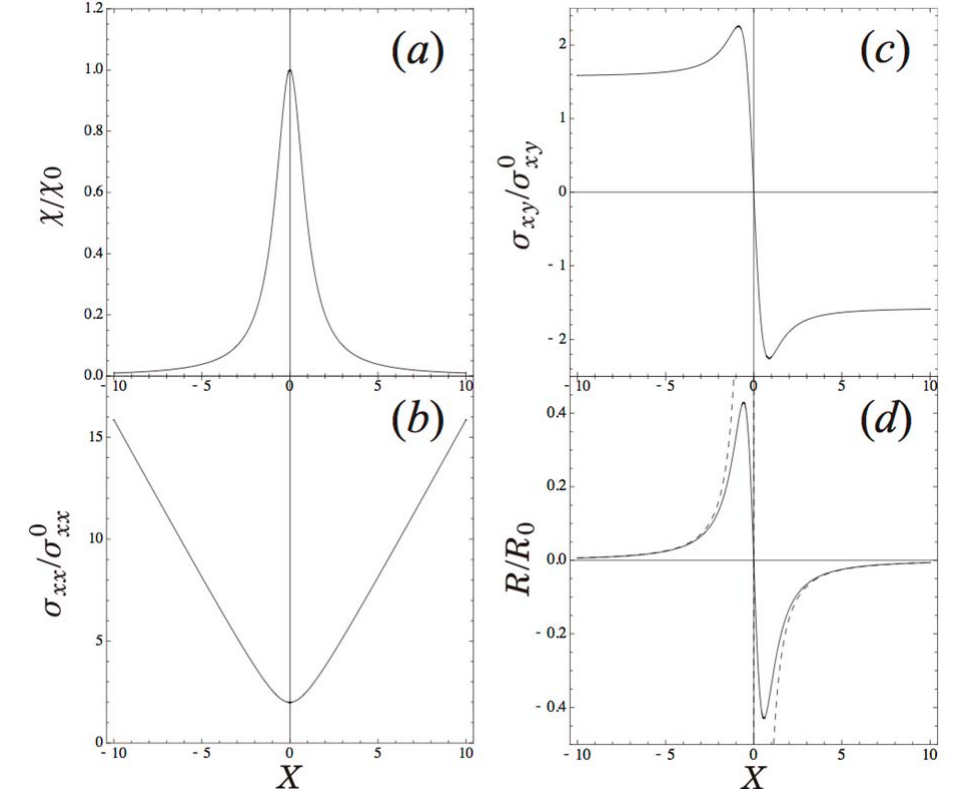
Figure 6. Chemical potential ( μ ) dependences of: ( a ) orbital susceptibility, χ ; ( b ) diagonal conductivity, σ ; ( c ) Hall conductivity, σ ; and ( d ) Hall coefficient, R , respectively, based xx xy on Reference 79. Here X = μ / Г , Г being the damping constant, χ σ = e 2 /2 π 2 , and σ 0 = e 3 v 2 H /4 π 2 c Г , respectively. The broken lines in Figure 6d for Hall 0 xy coefficient correspond to the inverse of carrier density of either electrons or